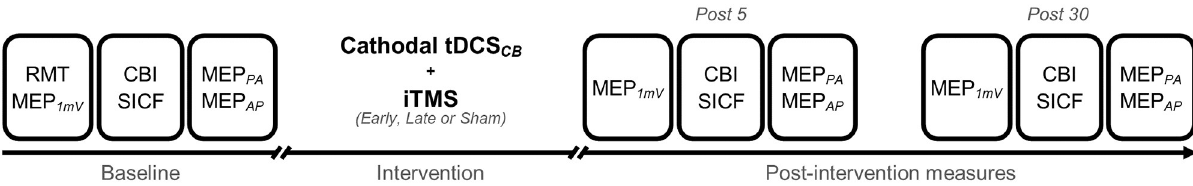
Fig 1. Experimental protocol. RMT, resting motor threshold; MEP , standard MEP of ~ 1 mV at baseline; CBI, cerebellar-brain inhibition; SICF, 1mV short-interval intracortical facilitation; MEP PA , standard MEP of ~ 0.5 mV at baseline with PA orientation; MEP AP , standard MEP of ~ 0.5 mV at baseline with AP orientation; tDCS , transcranial direct current stimulation applied to the cerebellum; iTMS, I-wave periodicity repetitive transcranial CB magnetic stimulation.